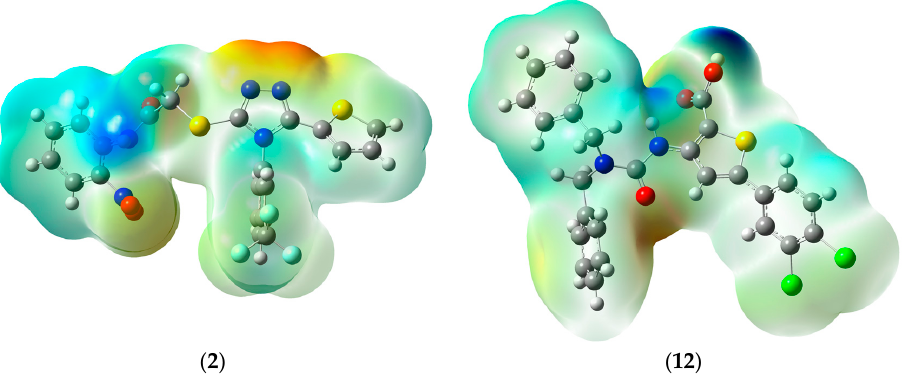
Figure 4. Molecular electrostatic potential (MEP) of 2 and 12 .